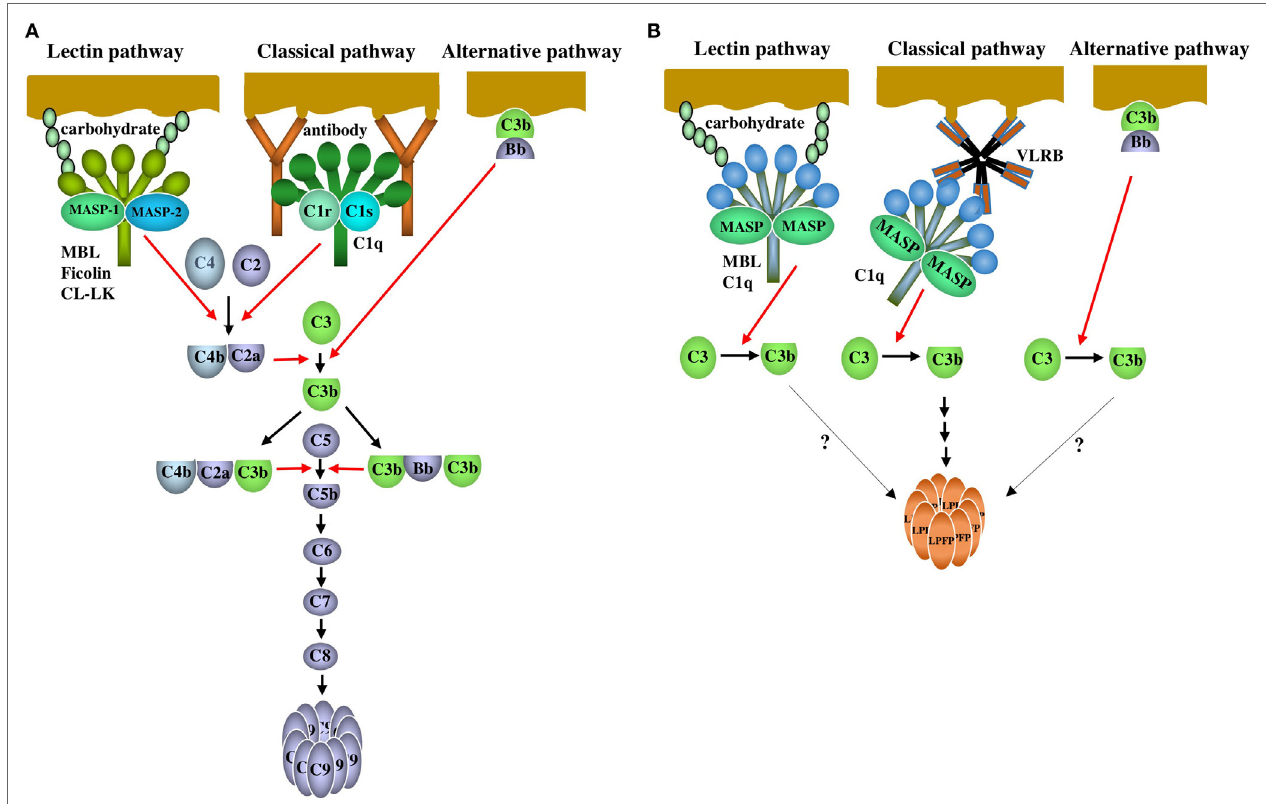
FiguRe 1 | The complement system of mammals and agnathans. (A) Mammalian complement system. Lectin pathway: the lectin pathway is initiated by the binding of serum collagenous lectins [mannose-binding lectin (MBL), ficolin or CL-LK] to carbohydrates on pathogens. The lectins are complexed with MASP-1 and MASP-2. MASP-1 is auto-activated, and in turn, activates MASP-2. Activated MASP-2 cleaves C4 and C2 to generate a bimolecular C4bC2a complex. MASP-1 is also able to cleave C2. The C4bC2a complex acts as a C3 convertase that cleaves C3 into C3a and C3b. The trimolecular complex C4bC2aC3b acts as a C5 convertase cleaving C5 into C5a and C5b. Classical pathway: the classical pathway is initiated by the binding of C1 to antigen-antibody (IgG and IgM) complexes through C1q. C1r is auto-activated, and in turn activates C1s. Activated C1s cleaves C4 and C2 to generate a C3 convertase C4bC2a, followed by C3 and C5 activation as is the case with the lectin pathway. Alternative pathway: Factor B bound to C3b on the surface of pathogens is cleaved by factor D to generate Bb. The bimolecular C3bBb complex acts as a C3 convertase. C3b forms a trimolecular complex with C3bBb, which acts as a C5 convertase. After C5b is generated via the three activation pathways, C5b, C6, C7, C8, and C9 are assembled sequentially, leading to the polymerization of C9 (lytic pathway). (B) Agnathan complement system. Lectin pathway: MBL forms a complex with MBL-associated serine proteases (MASP) (MASP-1, MASP-A, and